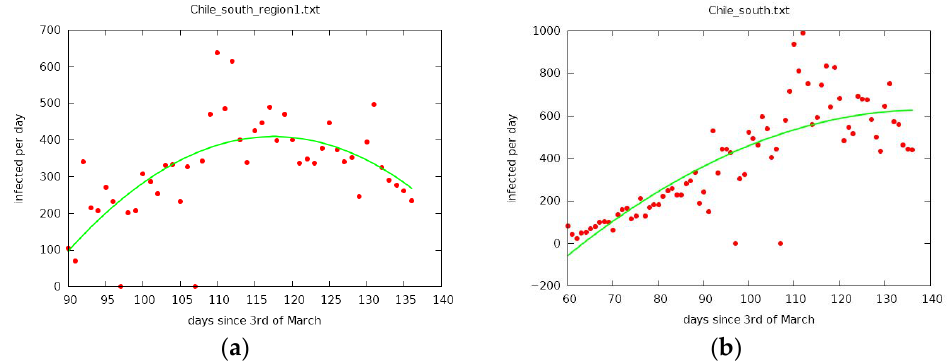
Figure 8. Maximums of infection for ( a ) the first band and ( b ) south of Chile that correspond to maximums of parabolas. For the first band ( a ) the maximum is near the point 117 which means 28 June and for the South of Chile ( b ) it is near the point 140 which means 21 July.